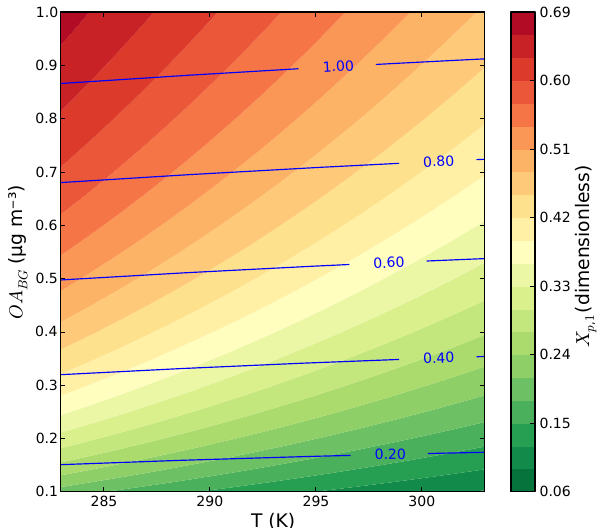
Fig. 2. Sensitivity of the partitioning coefficient of the first bin ( X p, 1 ) and organic aerosol concentration ( C OA ) to temperature ( T ) and the background organic aerosol concentration (OA BG ). Shades indicate X p, 1 (dimensionless) and the blue contours C OA (µgm − 3 ).